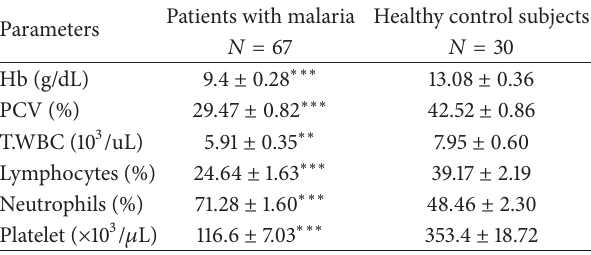
Table 2: Comparison of hematological parameters between the cases of P. falciparum malaria infection and healthy subjects.